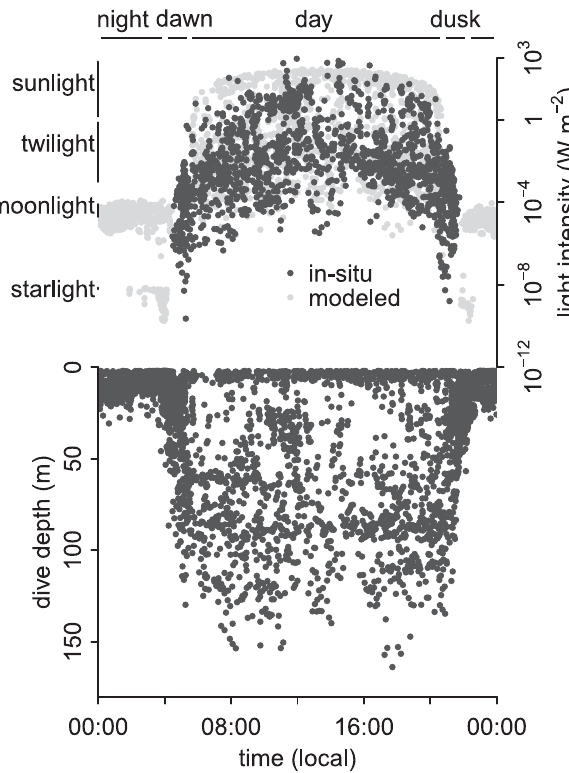
Figure 1. In-situ and modeled minimum light levels and associated maximum dive depths for 15 TDLR equipped murres across the 24 h period. Period duration and range of ambient light levels experienced from the sun, moon and stars are indicated.